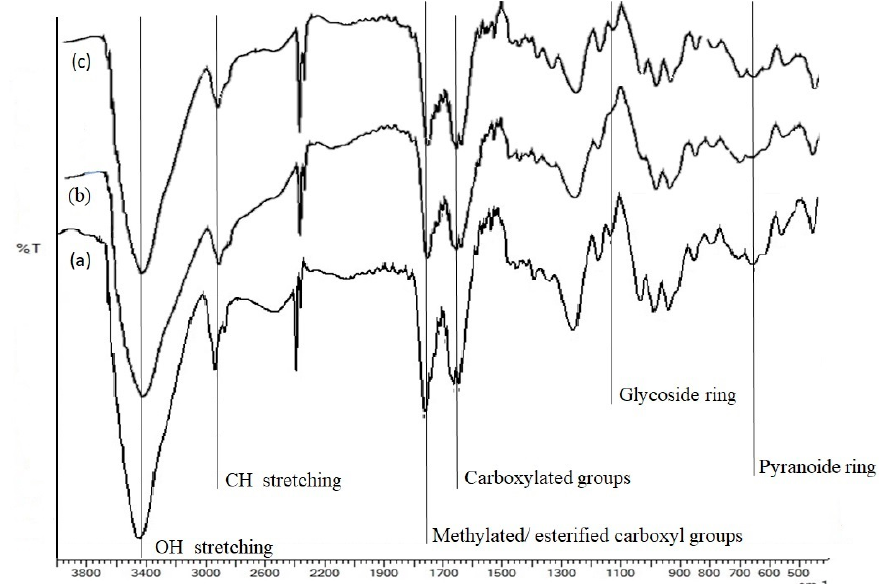
Figure 1. FTIR spectra of pectins in the 400 to 4000 cm − 1 region. Spectra of pectins from jujubes (PJ) of first harvesting, PJ1 (a), second harvesting, PJ2 (b) and third harvesting, PJ3 (c).